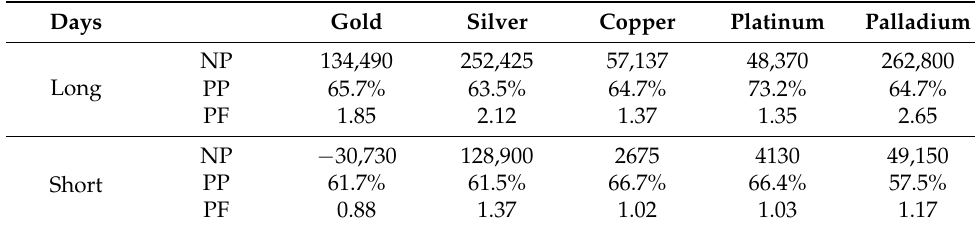
Table 8. Bollinger bands trading results of long/short strategies.